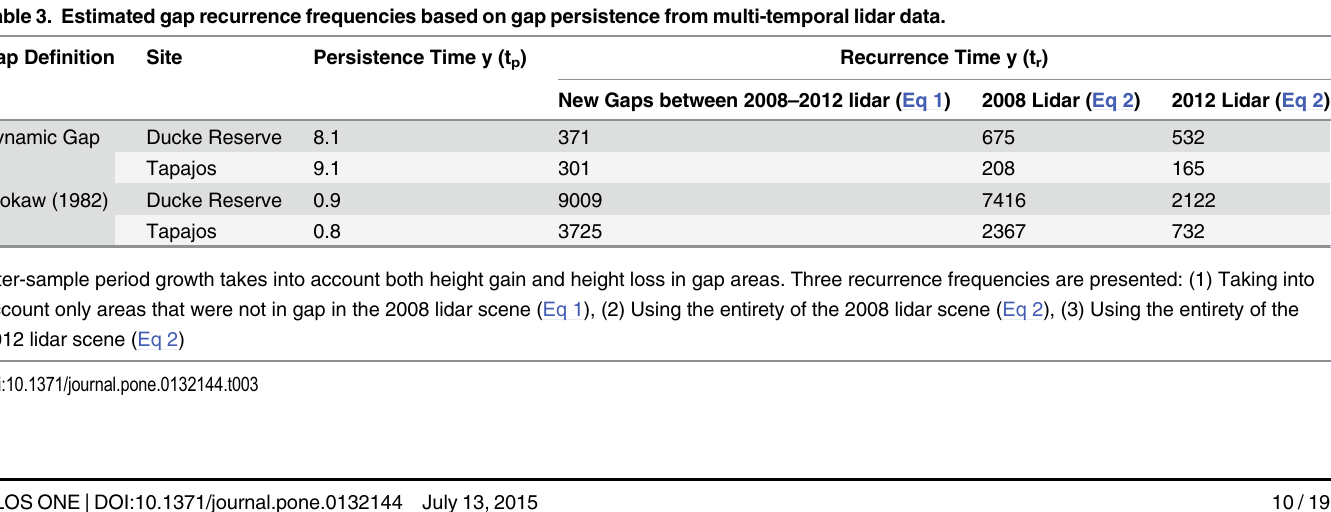
Table 3. Estimated gap recurrence frequencies based on gap persistence from multi-temporal lidar data.